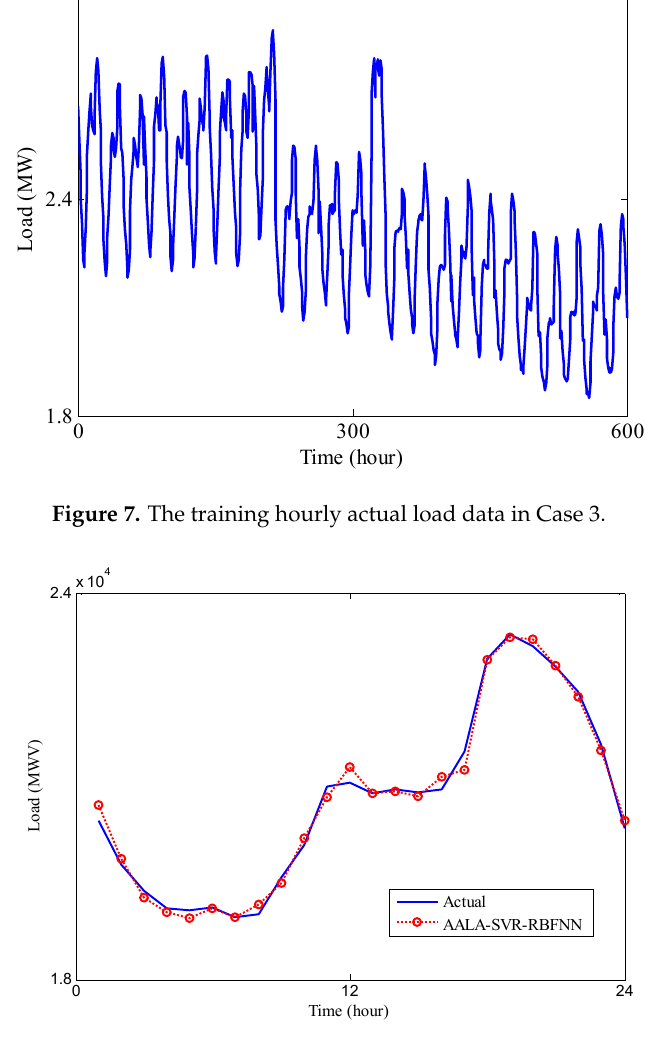
Figure 8. The forecasting results of the proposed AALA-SVR-RBFNN in Case 3.